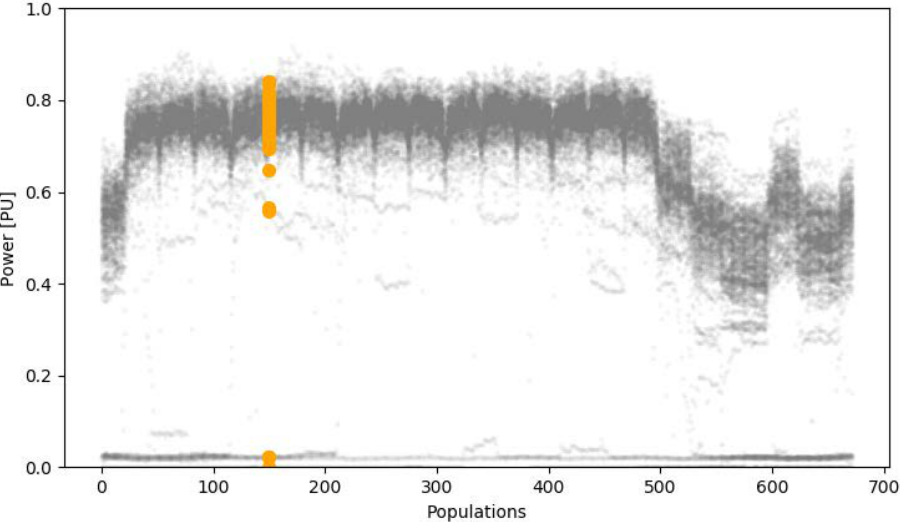
Figure 4. Available data samples aggregated in populations weekly wise visualization. For example, a single sampled quarter-hourly population is highlighted in orange.